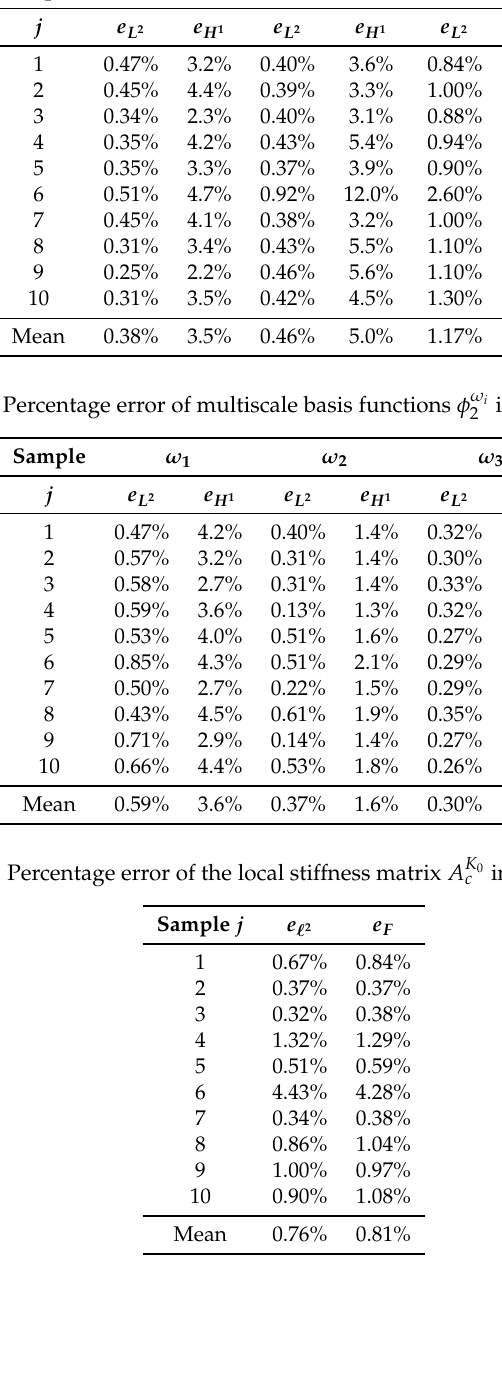
in experiment 1. 1